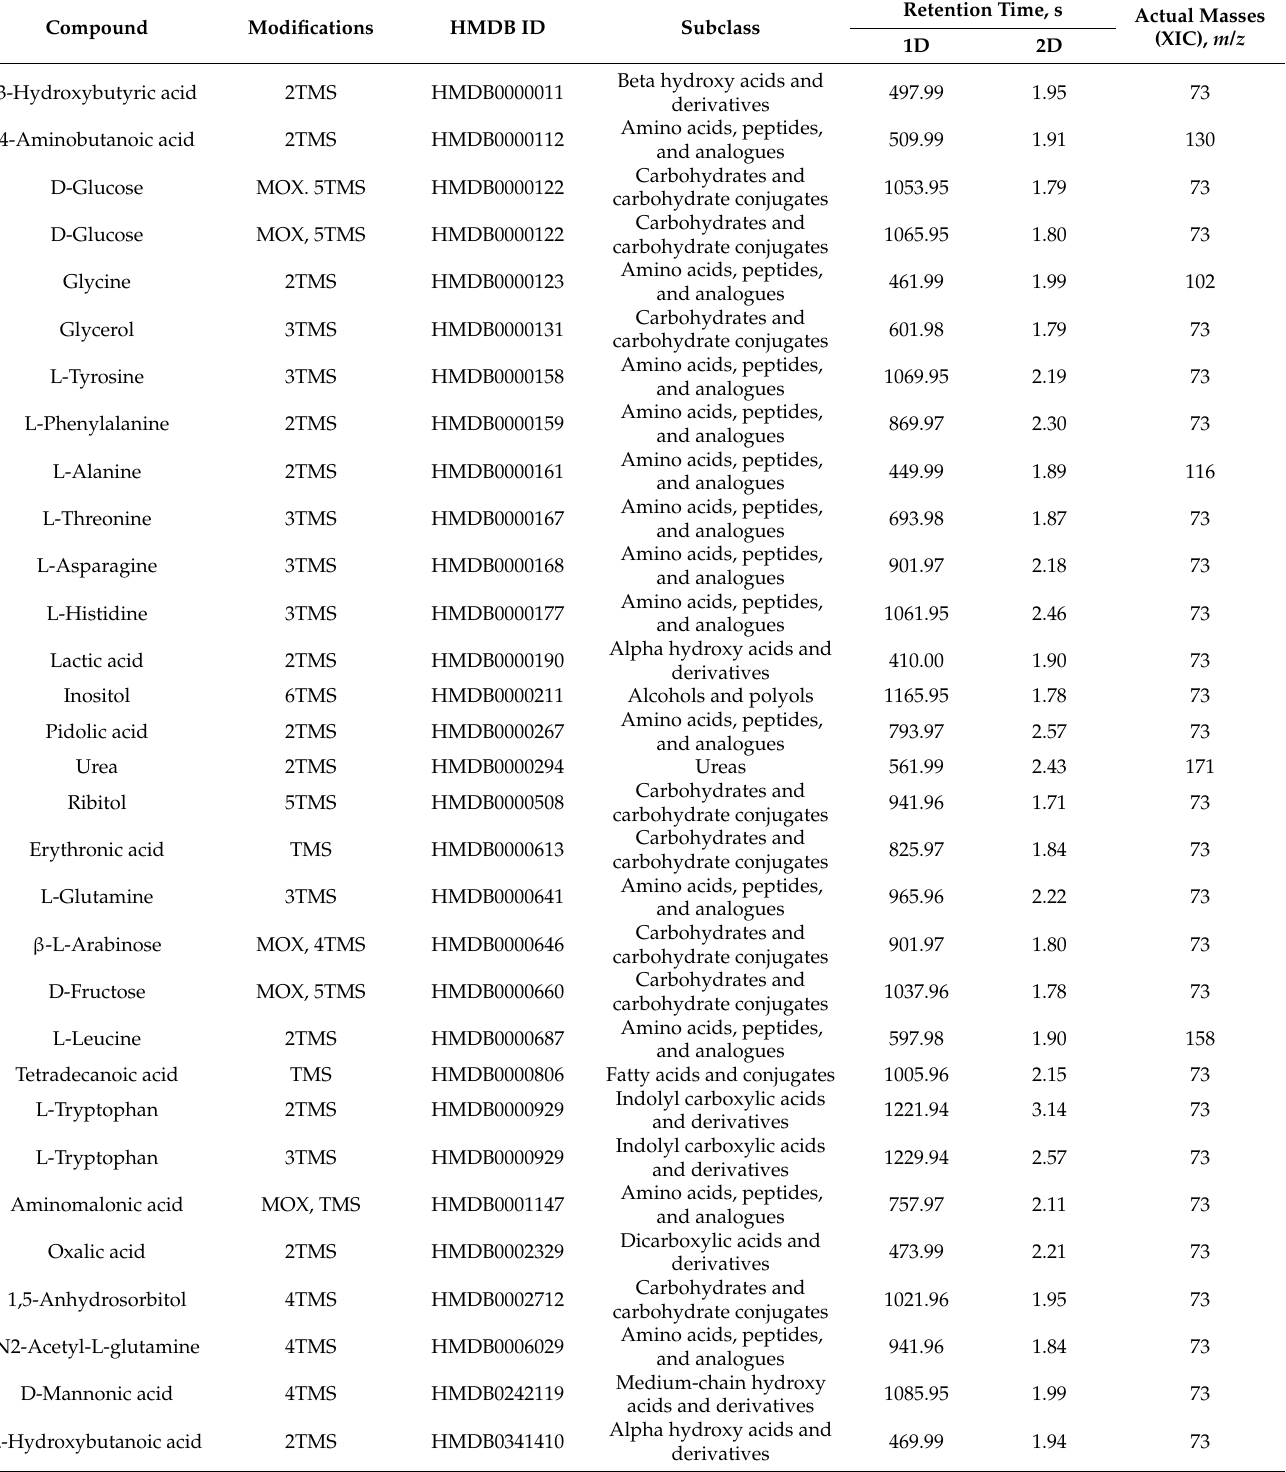
Table 1. GC × GC-MS identifications of selected blood plasma